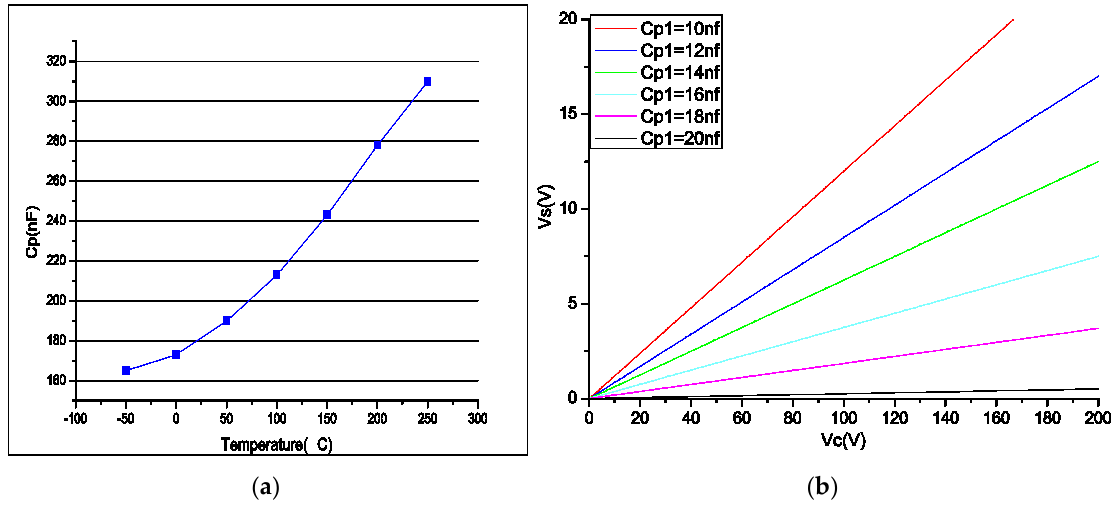
Figure 2. ( a ) Piezoelectric capacitance vs. temperature; ( b ) peak value curve of the driven and inference voltage.